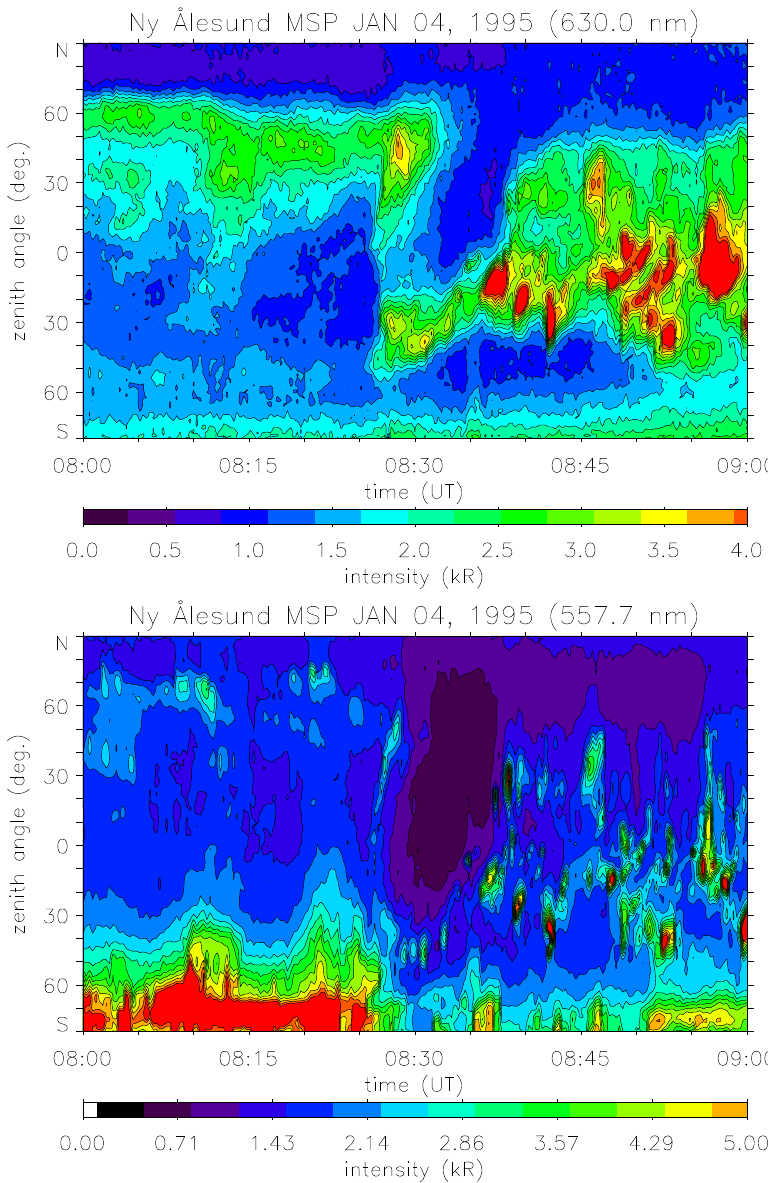
Fig. 2. Meridian scanning photometer observations from Ny ˚Alesund (76.1 ◦ MLAT) of line of sight auroral intensities versus zenith angle at the two wavelengths 630.0 (panel (a) and 557.7nm (panel (b) for 08:00–09:00UT on 4 January 1995, North (N) is up. Intensities in kRs are colour-coded according to the scale at the bottom of each